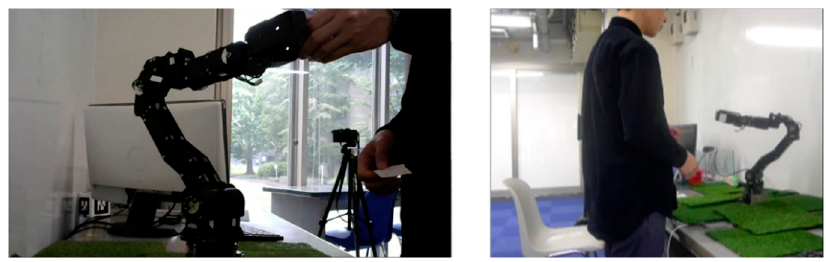
Figure 5. Snapshots of the